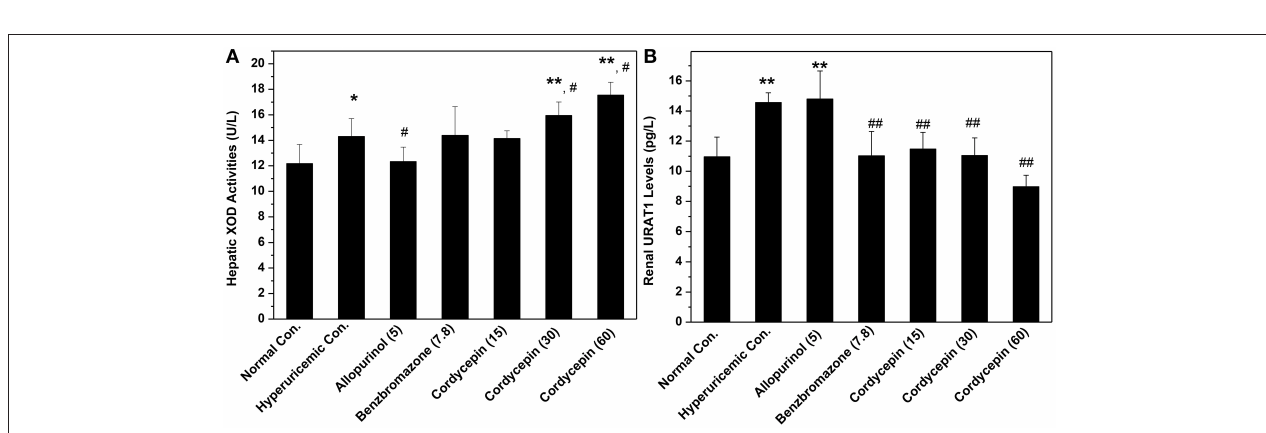
FIGURE 5 | Actions of cordycepin on (A) XOD activities and (B) URAT1 protein by Elisa. * P < 0.05, ** P < 0.01 vs. normal control; # P < 0.05, ## P < 0.01 vs. hyperuricemic control.